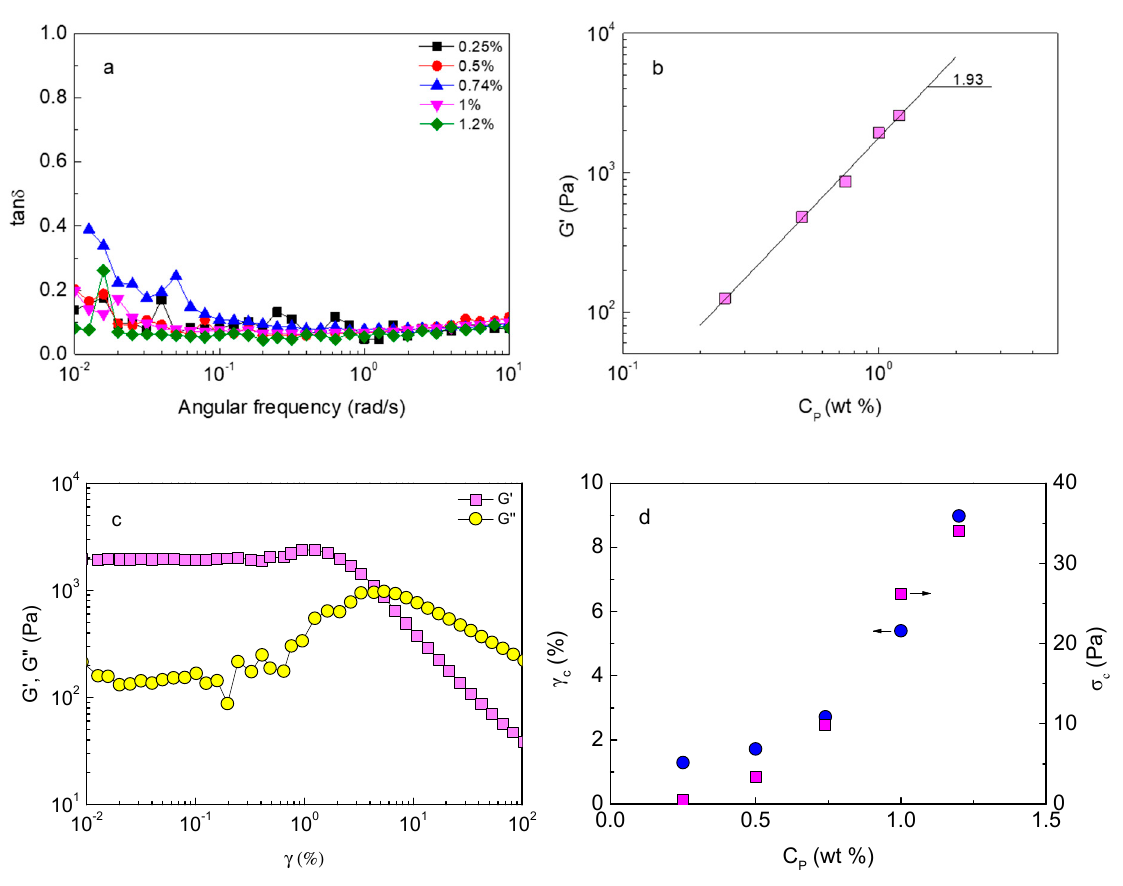
Figure 2. ( a ) Angular frequency dependence of tan δ at various concentrations, ( b ) G’ at 1 Hz obtained from the strain sweep data, ( c ) strain sweep of C p = 1 wt% sample at 1 Hz and ( d ) γ c , σ c versus C p of PAA-g-P(b-LL) in aqueous solutions at pH 8.8.